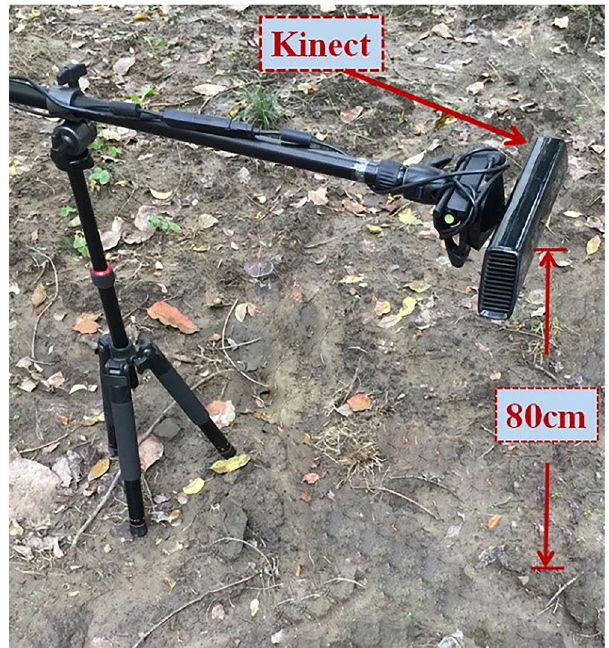
Figure 2. Image capture equipment